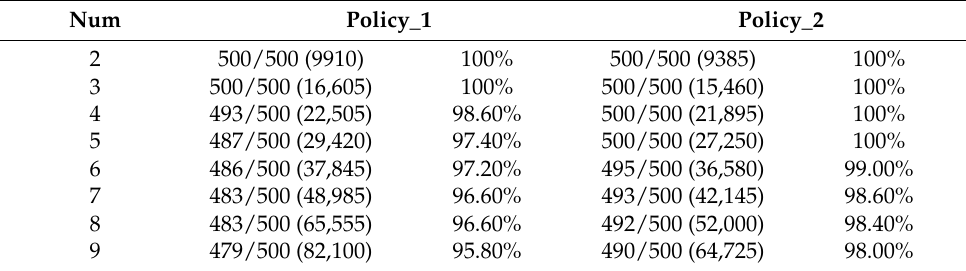
Table 3. Success rate of the cases with different numbers of